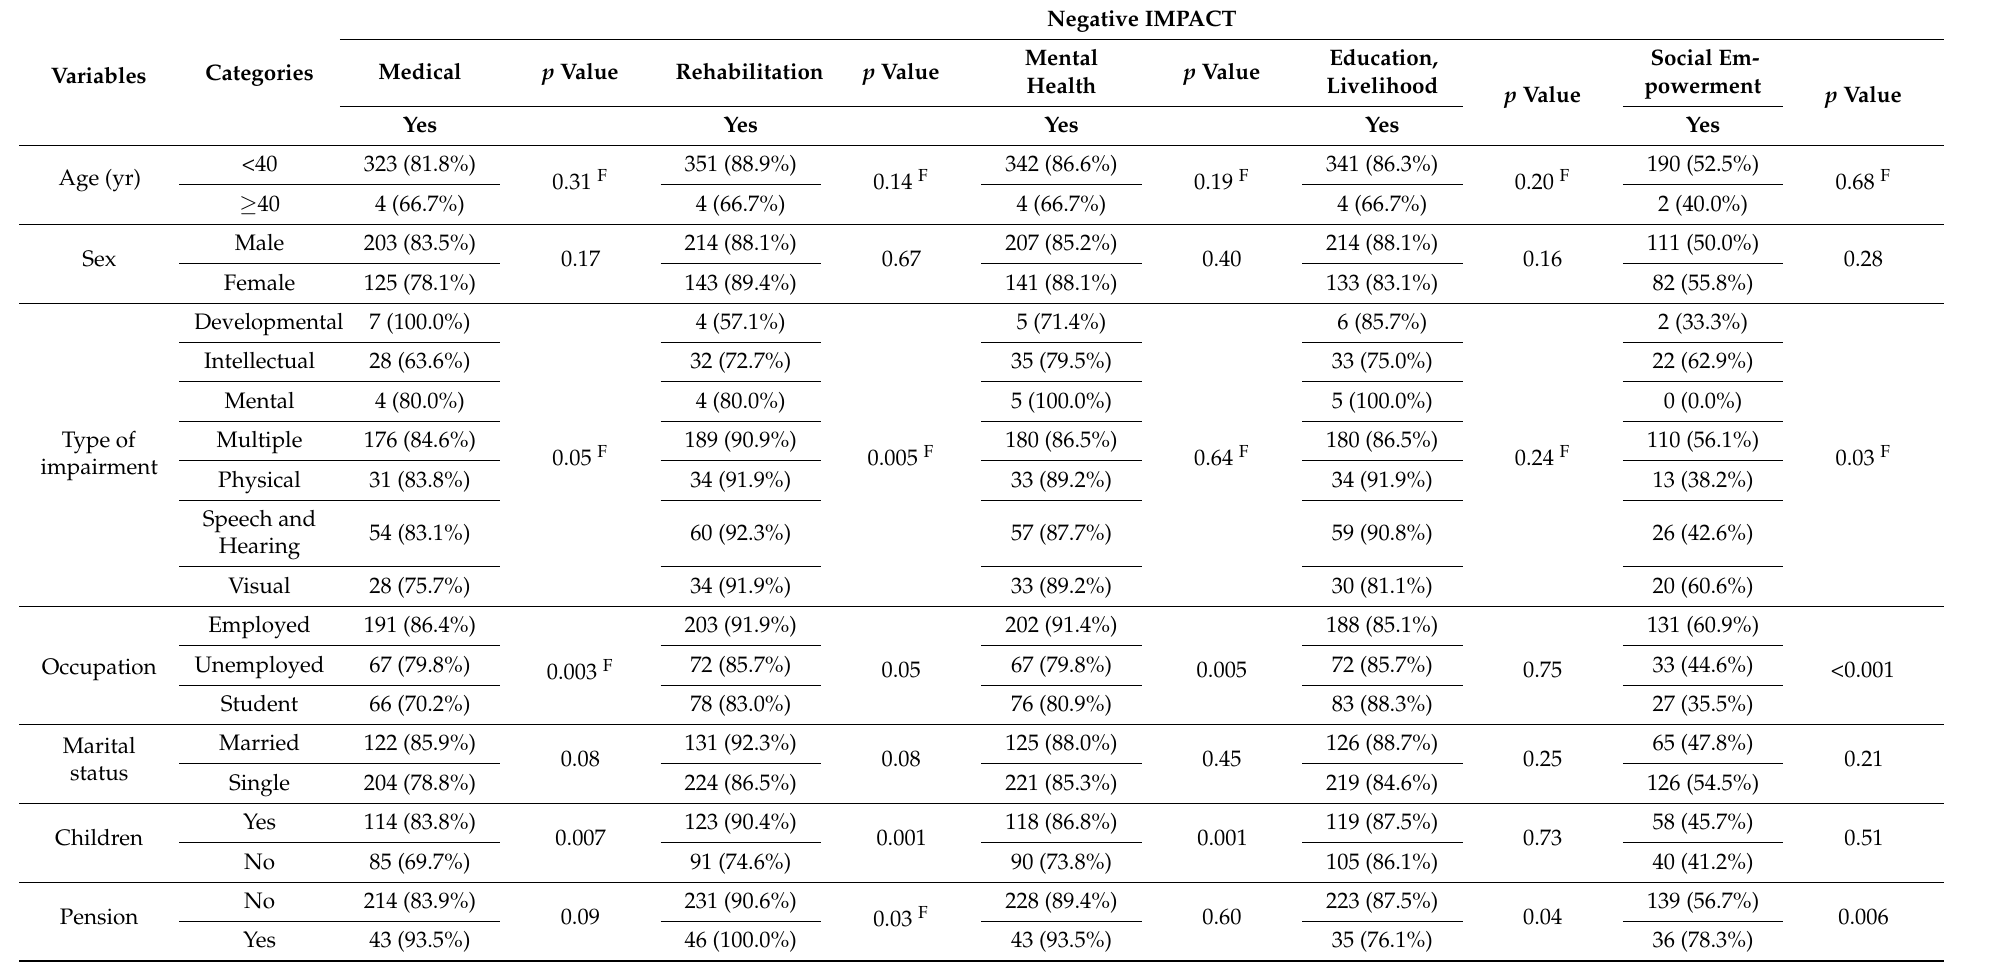
Table 4. Factors associated with the impact of